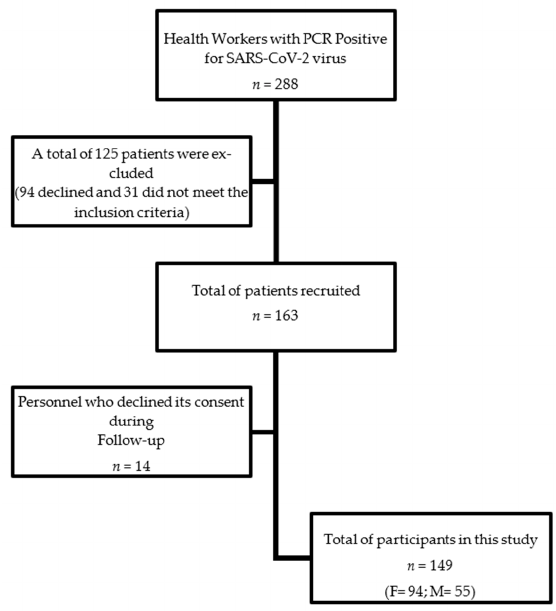
Figure 1. Flow chart of Study Population (F = Female; M = Male).